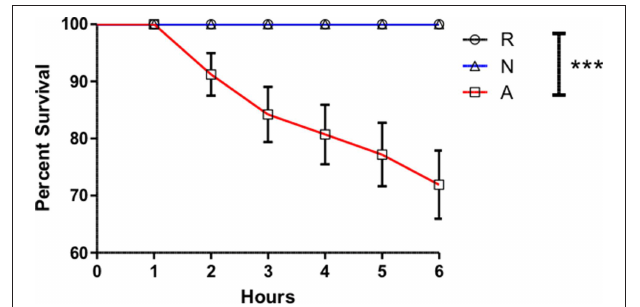
FIGURE 4 | Activated Heterorhabditis bacteriophora nematode Excreted/Secreted (ES) products are lethal to adult Drosophila melanogaster . Drosophila adults were injected with 69.0 nl of Ringer’s buffer (R) or 414 IJ-equivalent dose triple-concentrated ES products, either activated (A) or non-activated (N) and monitored for mortality every hour for 6h, at which point injected populations typically stabilized and no additional deaths were observed up to a 24-h time point. Each curve is comprised of measurements for three trials of 10 male and 10 female flies (*** p < 0.001).